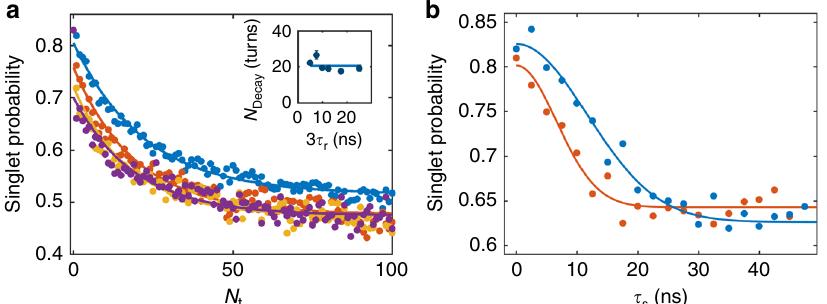
Fig. 4 In fl uence of the number of turns on spin mixing and motional narrowing. a Singlet probability as a function of the number of turns N t for different time per turn 3 τ r at B = 90 mT. The blue , red , orange and purple curves correspond, respectively, to 5, 10, 18 and 25 nanoseconds per turn. The fast decay associated to the static phase is observed for small number of turns. The data after the static phase are fi tted with an exponential decay with a characteristic number of turns N Decay . Inset : Extracted N Decay as a function of 3 τ r . The solid line is a constant fi t to the data, which slightly depends on the gate voltage con fi guration (see Supplementary Note 6). b Singlet probability as a function τ s for N t equal to one and obtained by increasing τ r (electron displacement with minimized transfer phase) at B = 90 mT. The corresponding singlet probability as a function of τ s , where the electrons are static in the (0, 1, 1) charge con fi guration at 90 mT is plotted in orange for comparison. The data are fi tted with a Gaussian decay with a characteristic time T 2 * equal to 16.4 ± 0.9 ns (9.4 ± 0.4 ns) for the blue ( orange ) curve . All the data presented in this fi gure are in a tunnelling condition slightly different than Figs. 2, 3 and 5 (see Supplementary Note 6 and Supplementary Fig. 6)